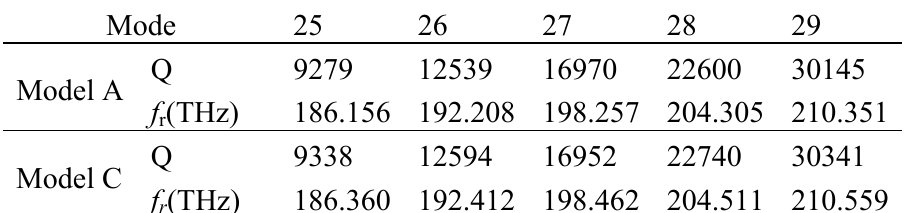
Table 3. Simulated Q factor and resonance frequency for Model A and